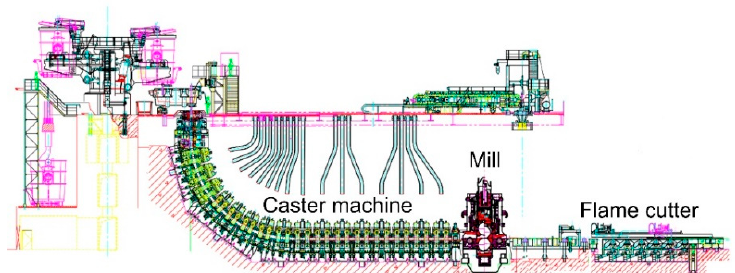
Figure 1. Layout of HHR 2 process.